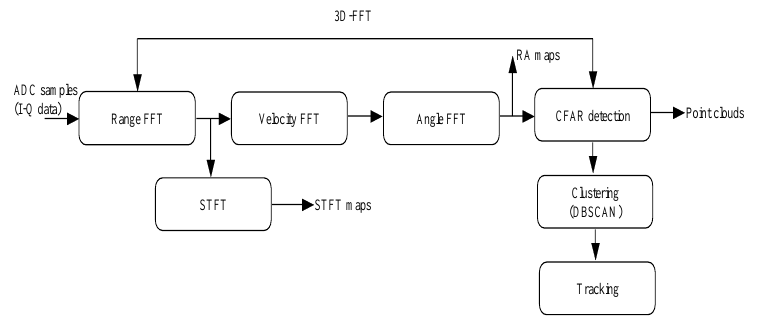
Figure 2. Radar signal processing and imaging. Adapted from